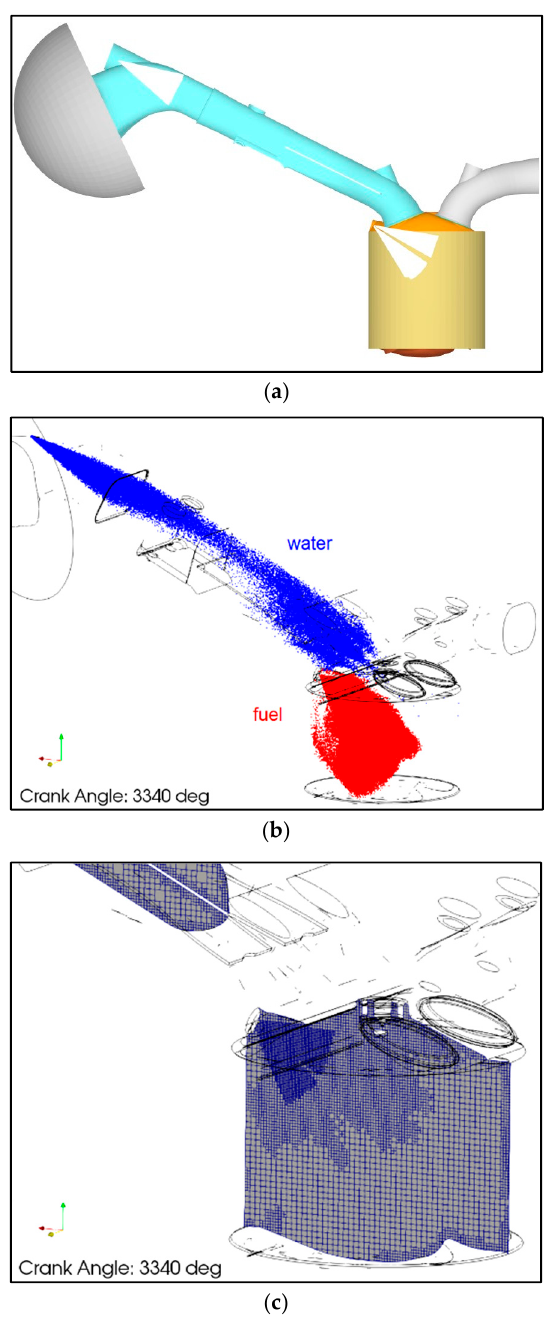
Figure 1. CFD engine model. ( a ) Geometry with injector locations; ( b ) Water and gasoline spray